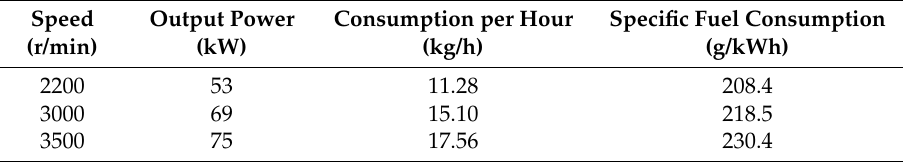
Table 3. Fuel consumption statistics of the power generation system.